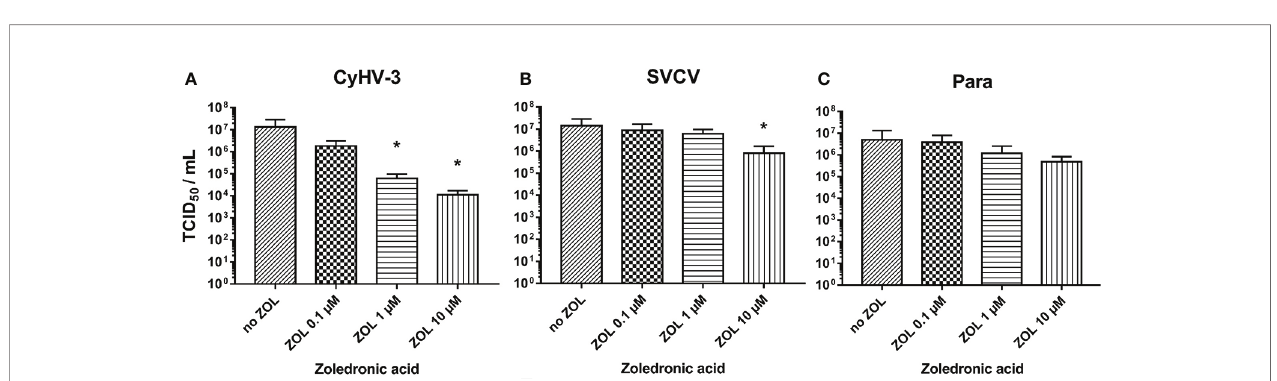
FIGURE 9 | Effect of zoledronic acid (ZOL) treatment on infectivity of (A) CyHV-3, (B) SVCV, and (C) Para. Data presented as a bar indicating mean TCID 50 /ml (+SD) at 7 days post-infection, from n = 6 replicates. * indicates a statistically signi fi cant difference at p<0.05 between control and the treatments. Analysis was performed with one-way ANOVA with subsequent pairwise multiple comparisons using the Holm-Sidak